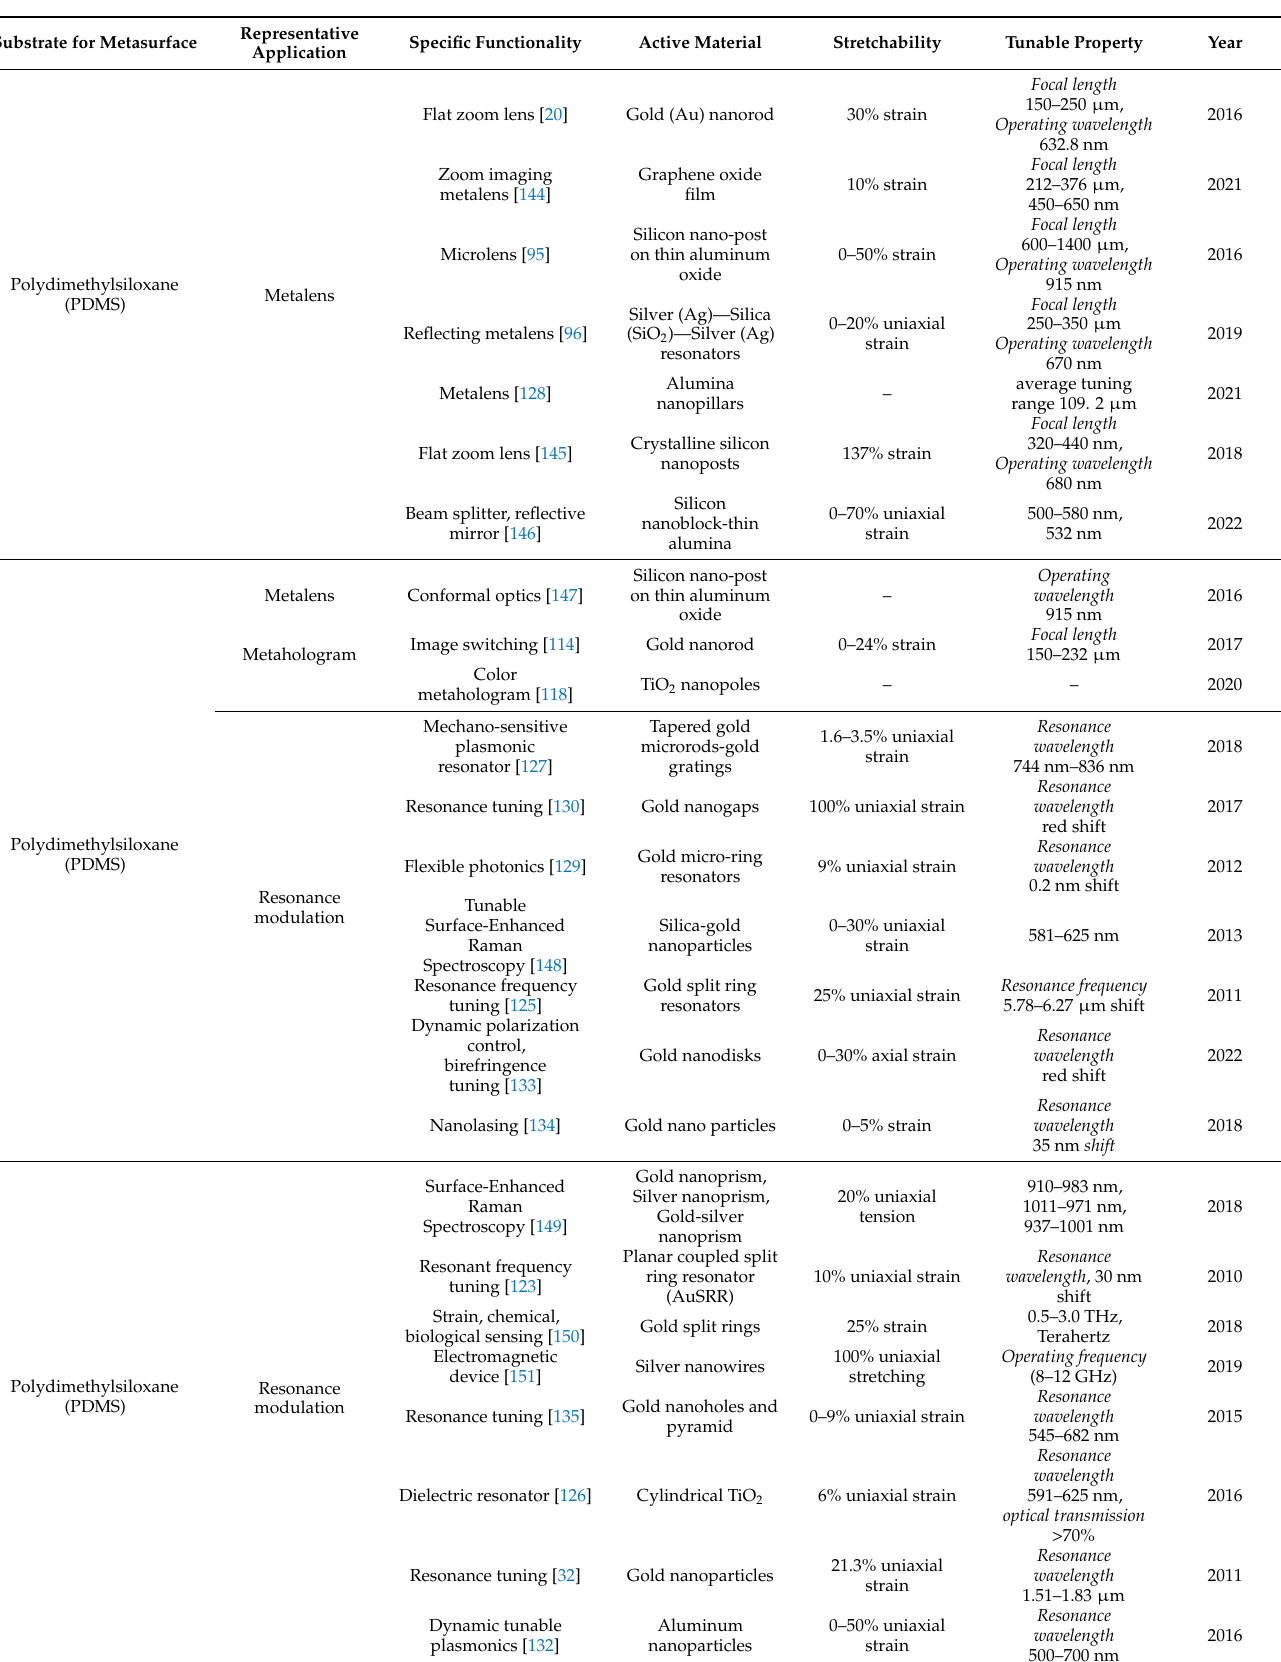
Table 2. Summary of representative metasurface applications and performance